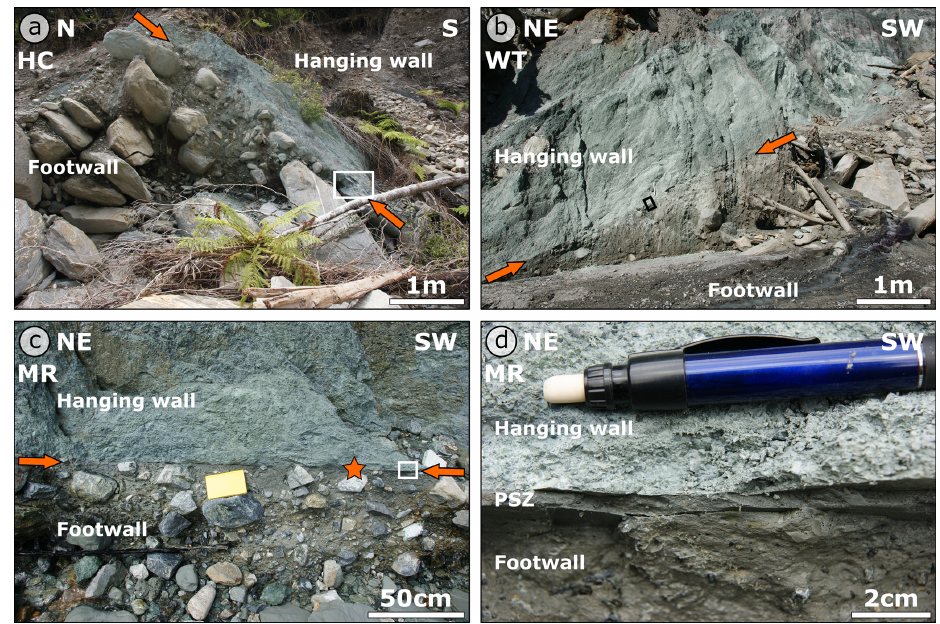
Figure 4. Outcrops of Alpine Fault Zone rocks. (a) Whereas pale green hanging wall cataclasites and larger Quaternary footwall gravels are clearly identified at Havelock Creek, the contacts and hence thickness of the PSZ (indicated by arrows) to overlying and underlying units, respectively, are only poorly constrained. The white box indicates position of Fig. 5a. (b) The PSZ at Waikukupa Thrust as indicated by arrows is well-defined and straight. The black box gives location of sample presented in Fig. 5c. (c) At Martyr River, hanging wall and footwall rocks are sharply separated by a well-defined PSZ (indicated by arrows). The white box indicates position of (d) . The star gives the sample location for the specimen shown in Fig. 5d. (d) The PSZ at Martyr River is between 1 and 2cm thick. HC: Havelock Creek; WT: Waikukupa Thrust; MR: Martyr